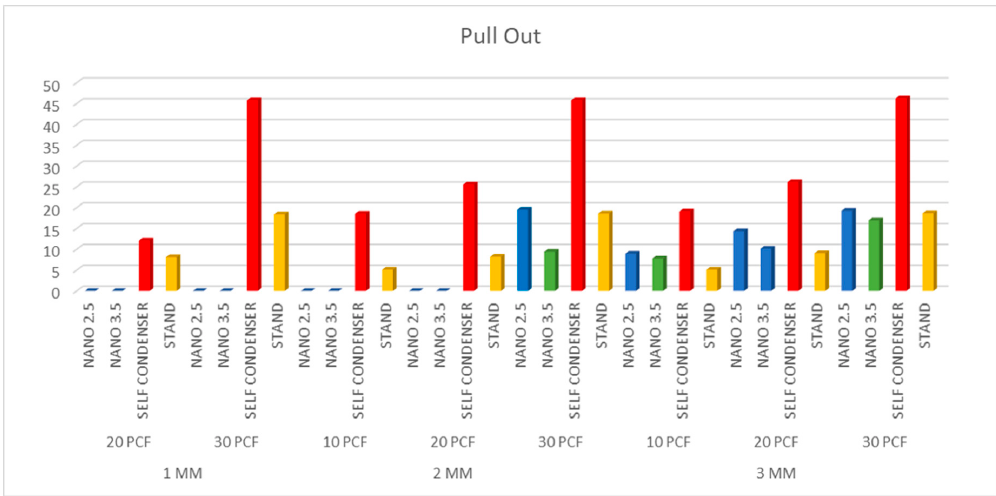
Figure 3. Insertion torque values for the four experimental groups. The self-condenser implant showed the highest ratio of stability.